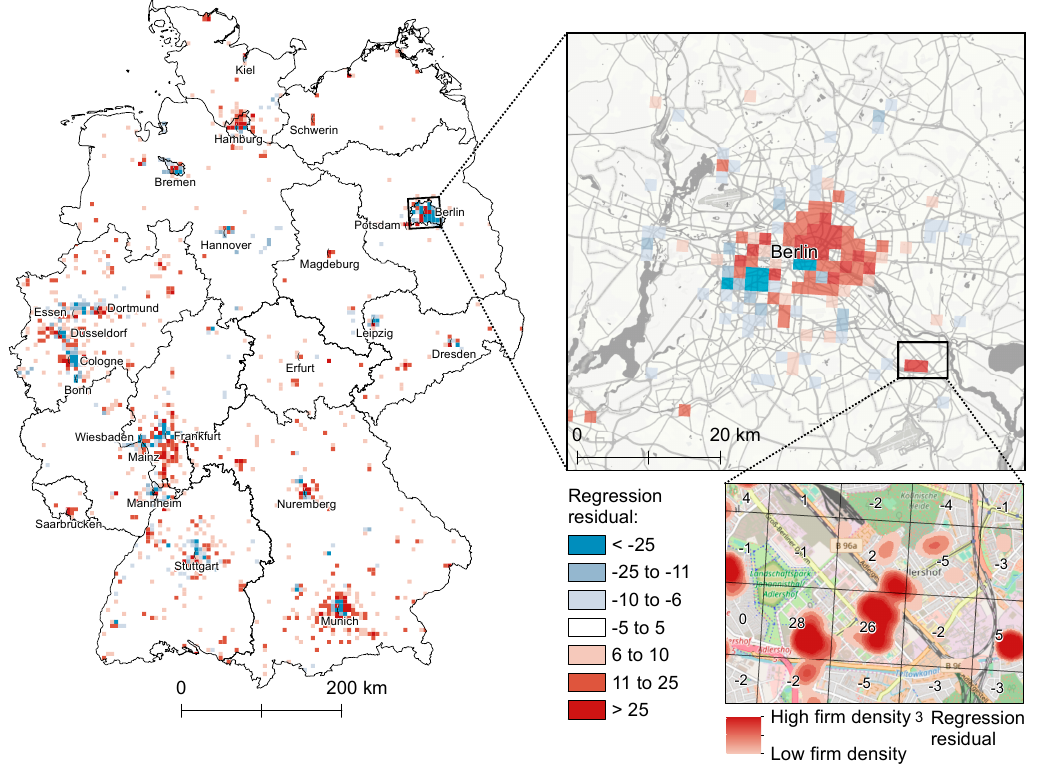
Figure 5. Regression residual aggregated at 5 km raster (left) and original 1 km grid (right).